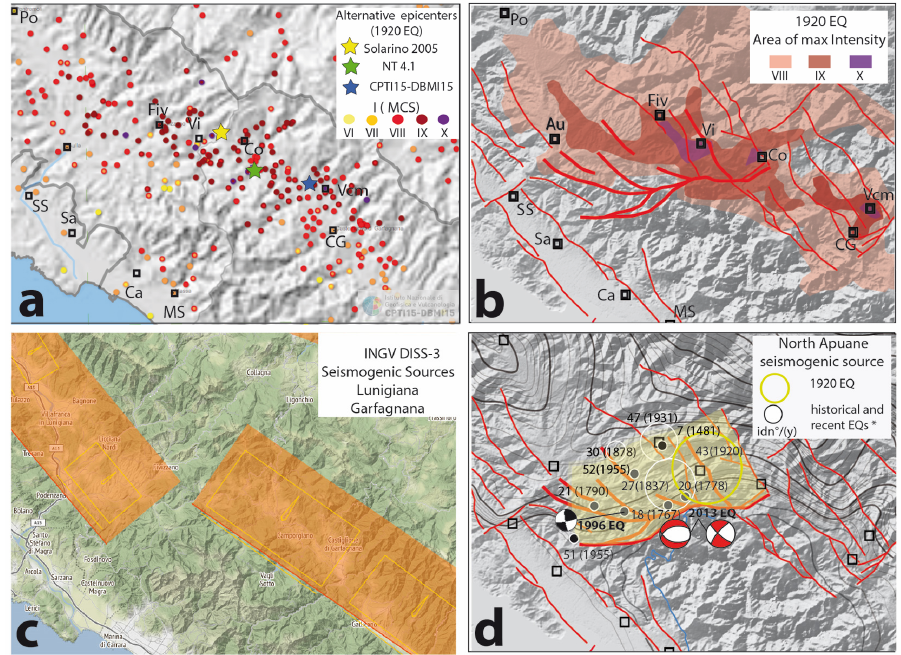
Figure 14. ( a ) Macroseismic field of the 1920 Fivizzano earthquake. MCS intensities are those of the database in [37], while epicentral positions are derived from different works (see legend). ( b ) Area of maximum intensity of the 1920 Fivizzano earthquake [35,37]. ( c ) Recognized seismogenic source according to DISS 3 [16]. ( d ) North Apuane Fault System architecture in surface and subsurface, with location of historical and recent earthquakes *. Light yellow represents the seismogenic source we inferred from Figure 7.